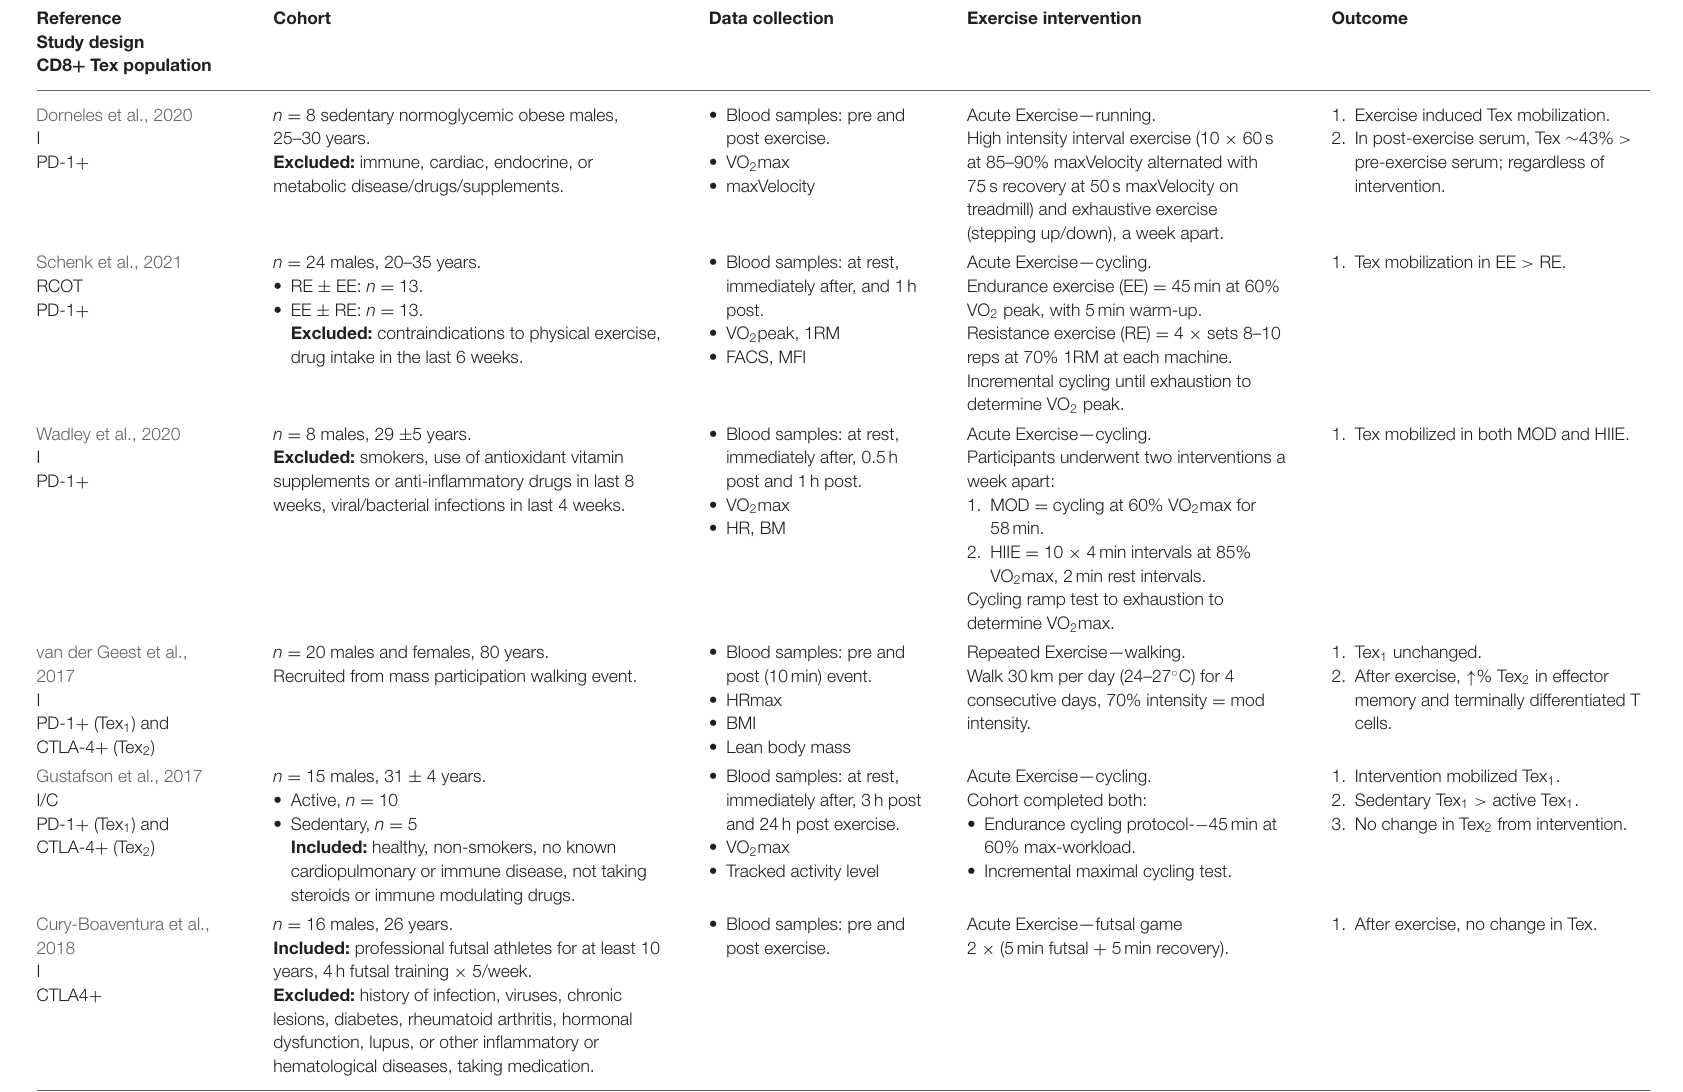
TABLE 3 | Summary of results concerning the influence of exercise on exhausted T (Tex) cells from included studies in this systematic